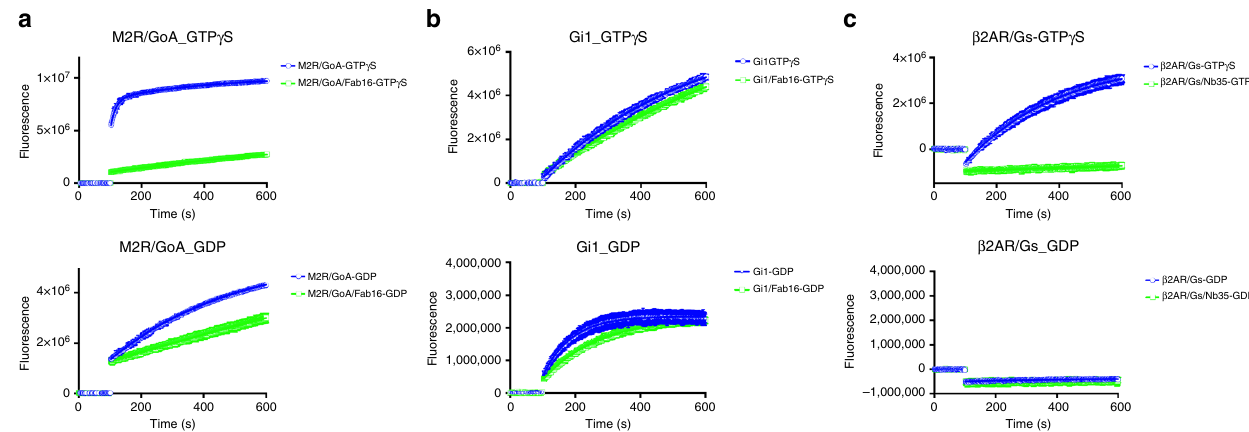
Fig. 4 Nucleotide-binding kinetics. a In fl uence of Fab16 on the nucleotide-binding kinetics of the puri fi ed M 2 R/G oA complex. Nucleotide binding was monitored by using BODIPY-FL-GTP γ S or BODIPY-FL-GDP. b In fl uence of Fab16 on the nucleotide release kinetics of G i1 . GDP release was monitored by BODIPY-FL-GTP γ S- or BODIPY-FL-GDP-binding kinetics under conditions where GDP release is the rate-limiting step. c Nucleotide binding to β 2AR/G s complex in the presence or absence of Nb35. The curves represent the mean ± standard error of three experiments